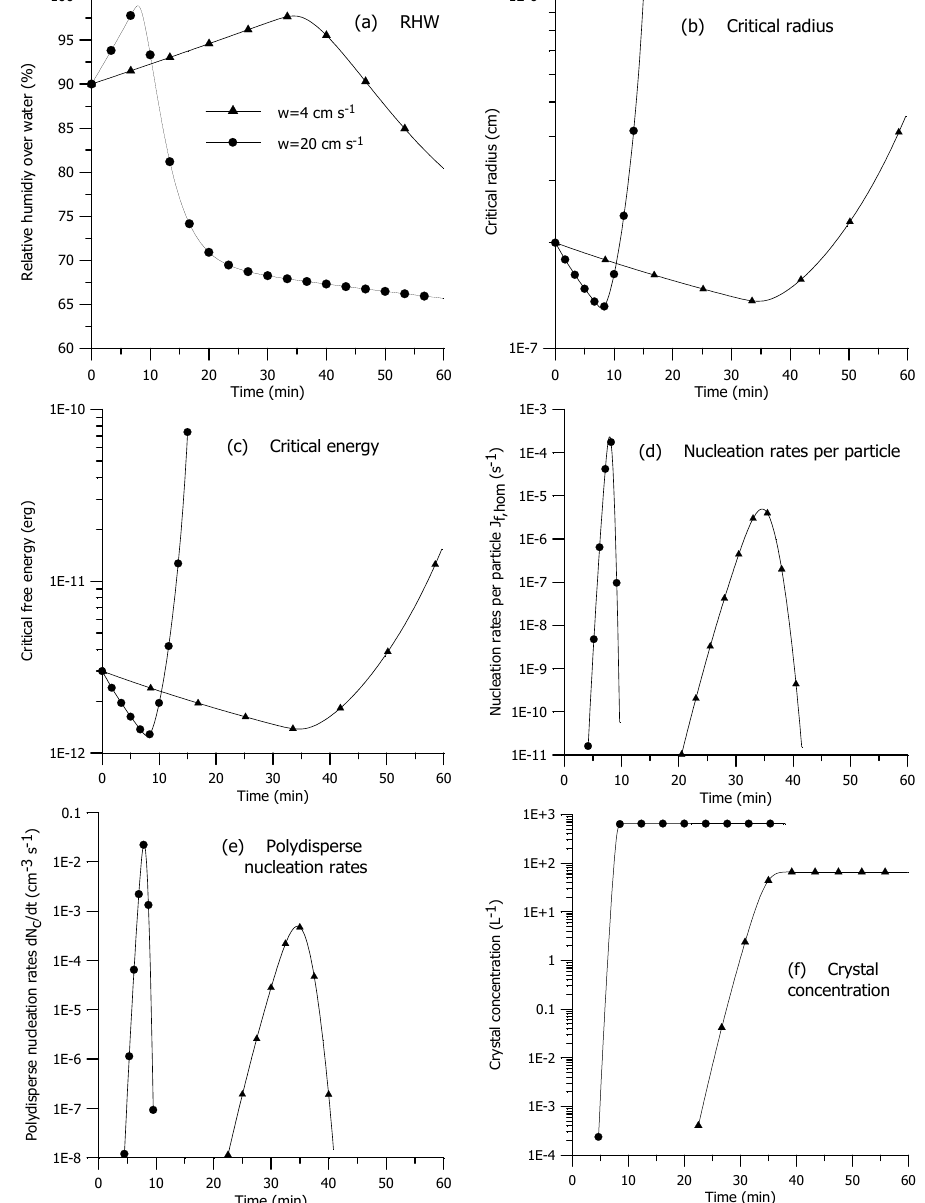
(d) homogeneous J f,hom r a 3 nucleation rates for a particle with Fig. 1. Kinetics of homogeneous nucleation at T 0c = -40 º C, Fig. 1. Kinetics of homogeneous nucleation at T 0c = − 40 ◦ C, RHW 0 = 90%, p 0 = 340hPa, N a = 200 cm − 3 and two vertical velocities, radius of 0.11 µ m; (e) polydisperse nucleation rates, R f,hom = RHW 0 = 90 %, p 0 =340 hPa, N a = 200 cm -3 and two vertical w = 4cms − 1 , and w = 20cms − 1 . (a) Relative humidity over water RHW, defined as 100 · S w , th ; (b) critical radius r cr ; (c) critical free energy dN fr /dt ; (f) crystal concentration. velocities, w =4 cm s -1 , and w =20 cm s -1 . (a) Relative humidity over water RHW , defined as 100xS w ; (b) critical radius r cr ; (c) 1F cr ; (d) homogeneous J f , hom r 3 a nucleation rates for a particle with radius of 0.11 µm; (e) polydisperse nucleation rates, R f , hom = d N fr / d t , critical free energy ∆ F cr ; defined by Eq. (18d); (f) crystal